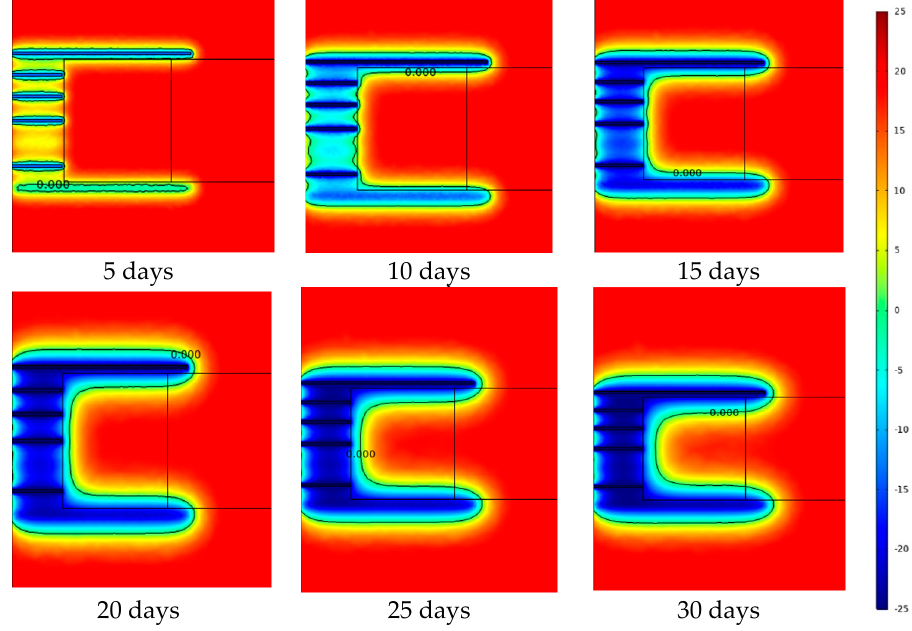
Figure 8. Temperature cloud map in Section 1.